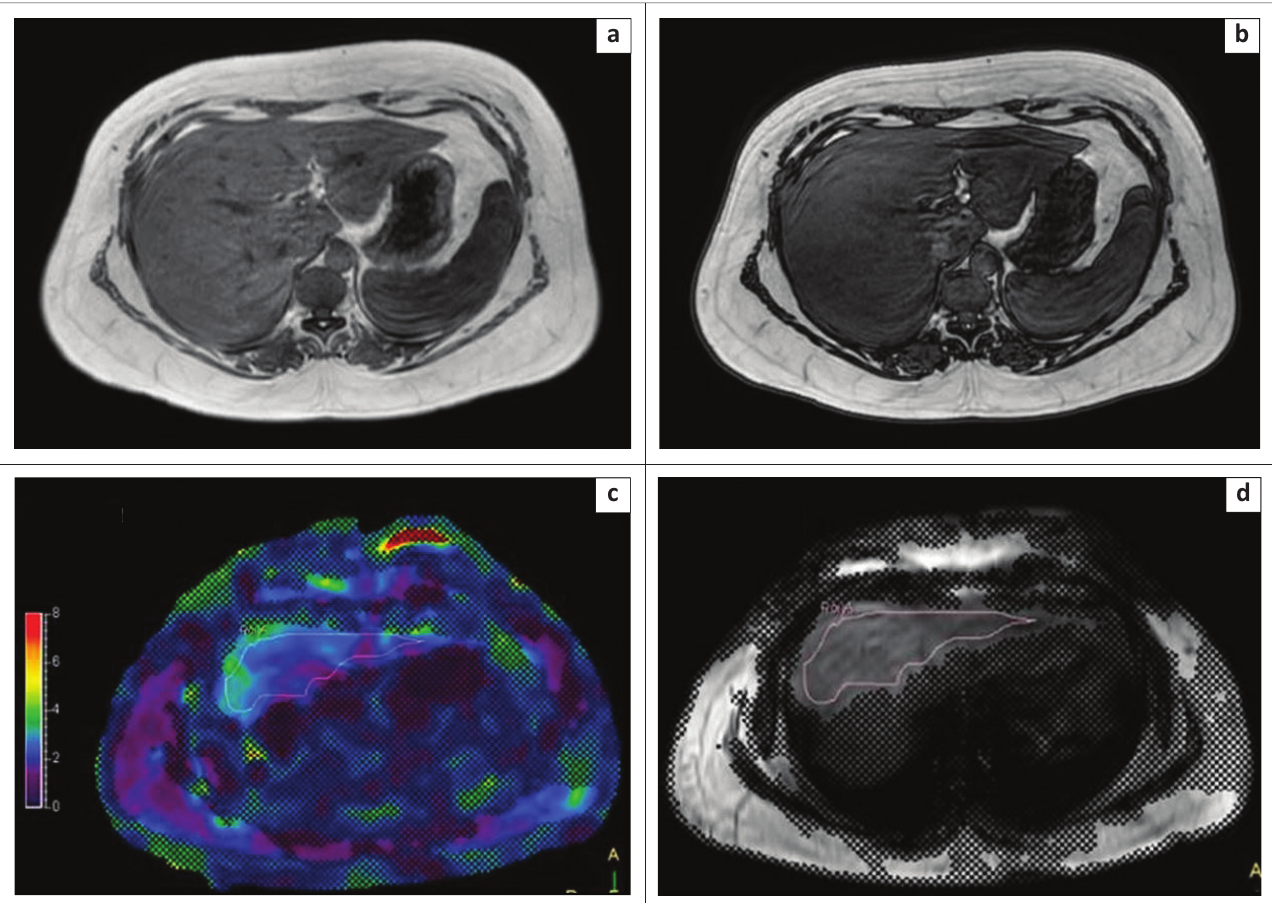
FIG URE 3: Non-alcoholic steatohepatitis. In-phase (a) and out-of-phase (b) images reveal a drop in signal on the out-of-phase image, indicating the presence of elevated hepatic fat. The colour (c) and magnitude (d) images reveal a liver stiffness measurement of 2.78 (Figure 3). Sixty-eight patients had fatty infiltration of liver on in-phase and out-of-phase images.